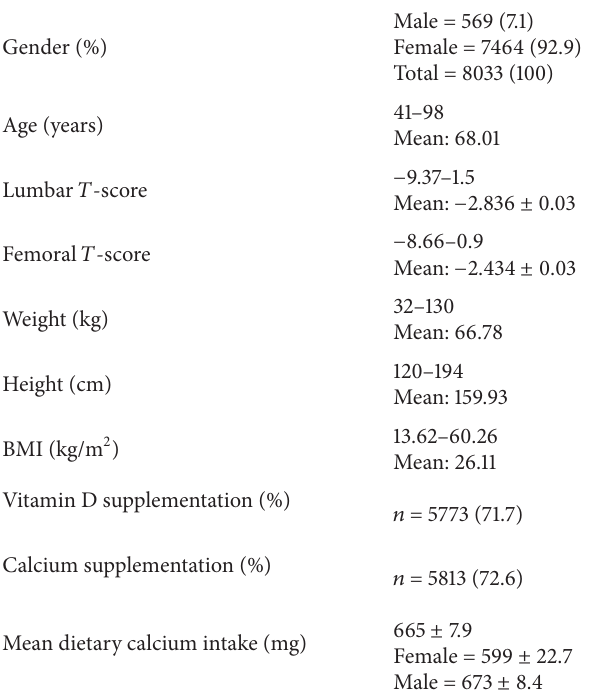
Table 1: The baseline characteristics of our